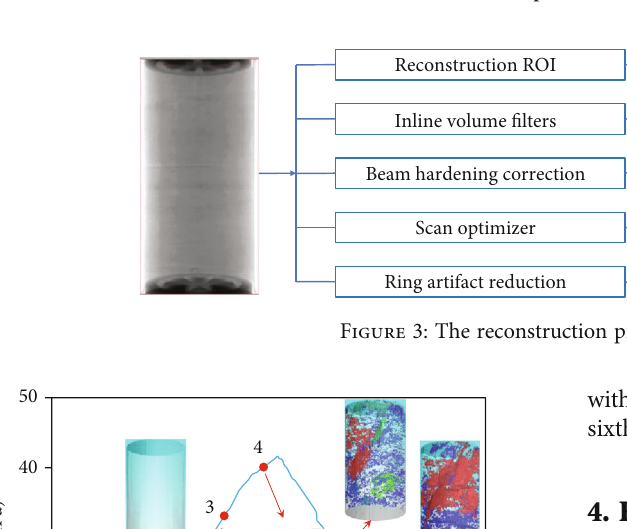
Figure 2: Experiment apparatus.